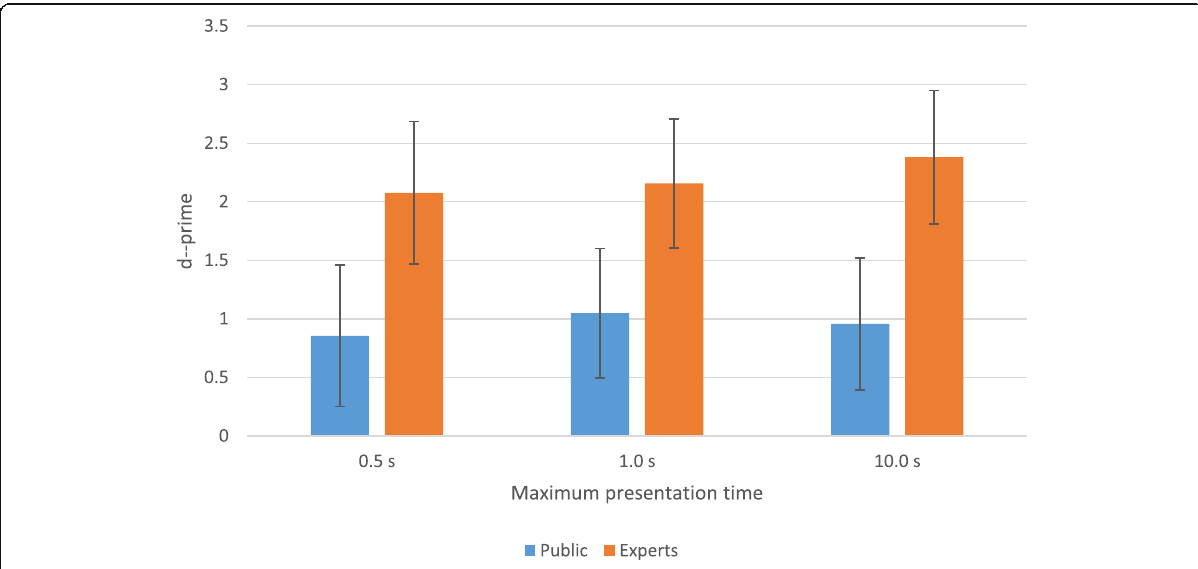
Fig. 5 Experiment 1 mean sensitivity scores and their error bars (standard deviation (SD)) as a function of expertise and exposure